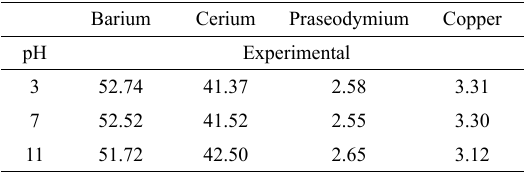
Table 3. Chemical composition (expressed in wt%) of powders.